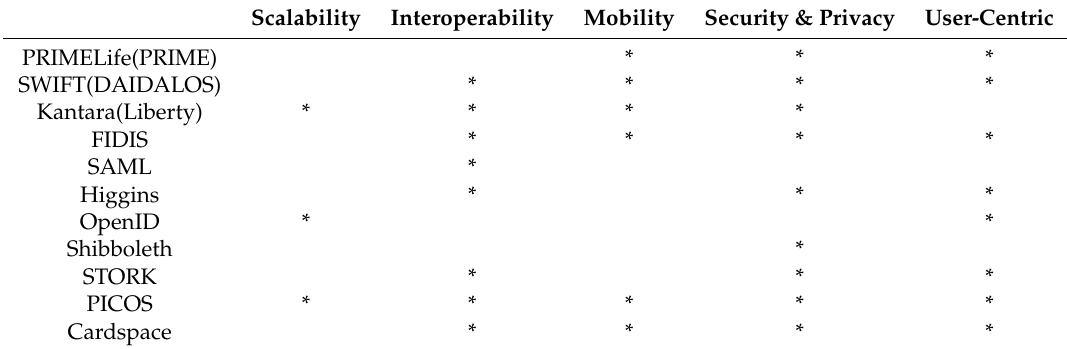
Table 1. Identity management initiatives